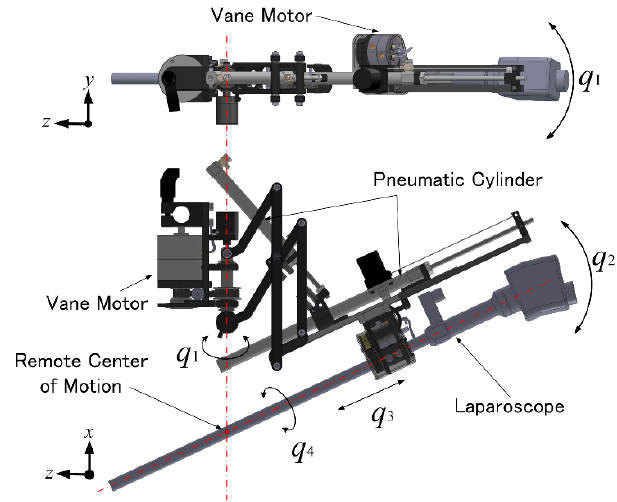
Figure 20. Overview of the robot used in the experiment.